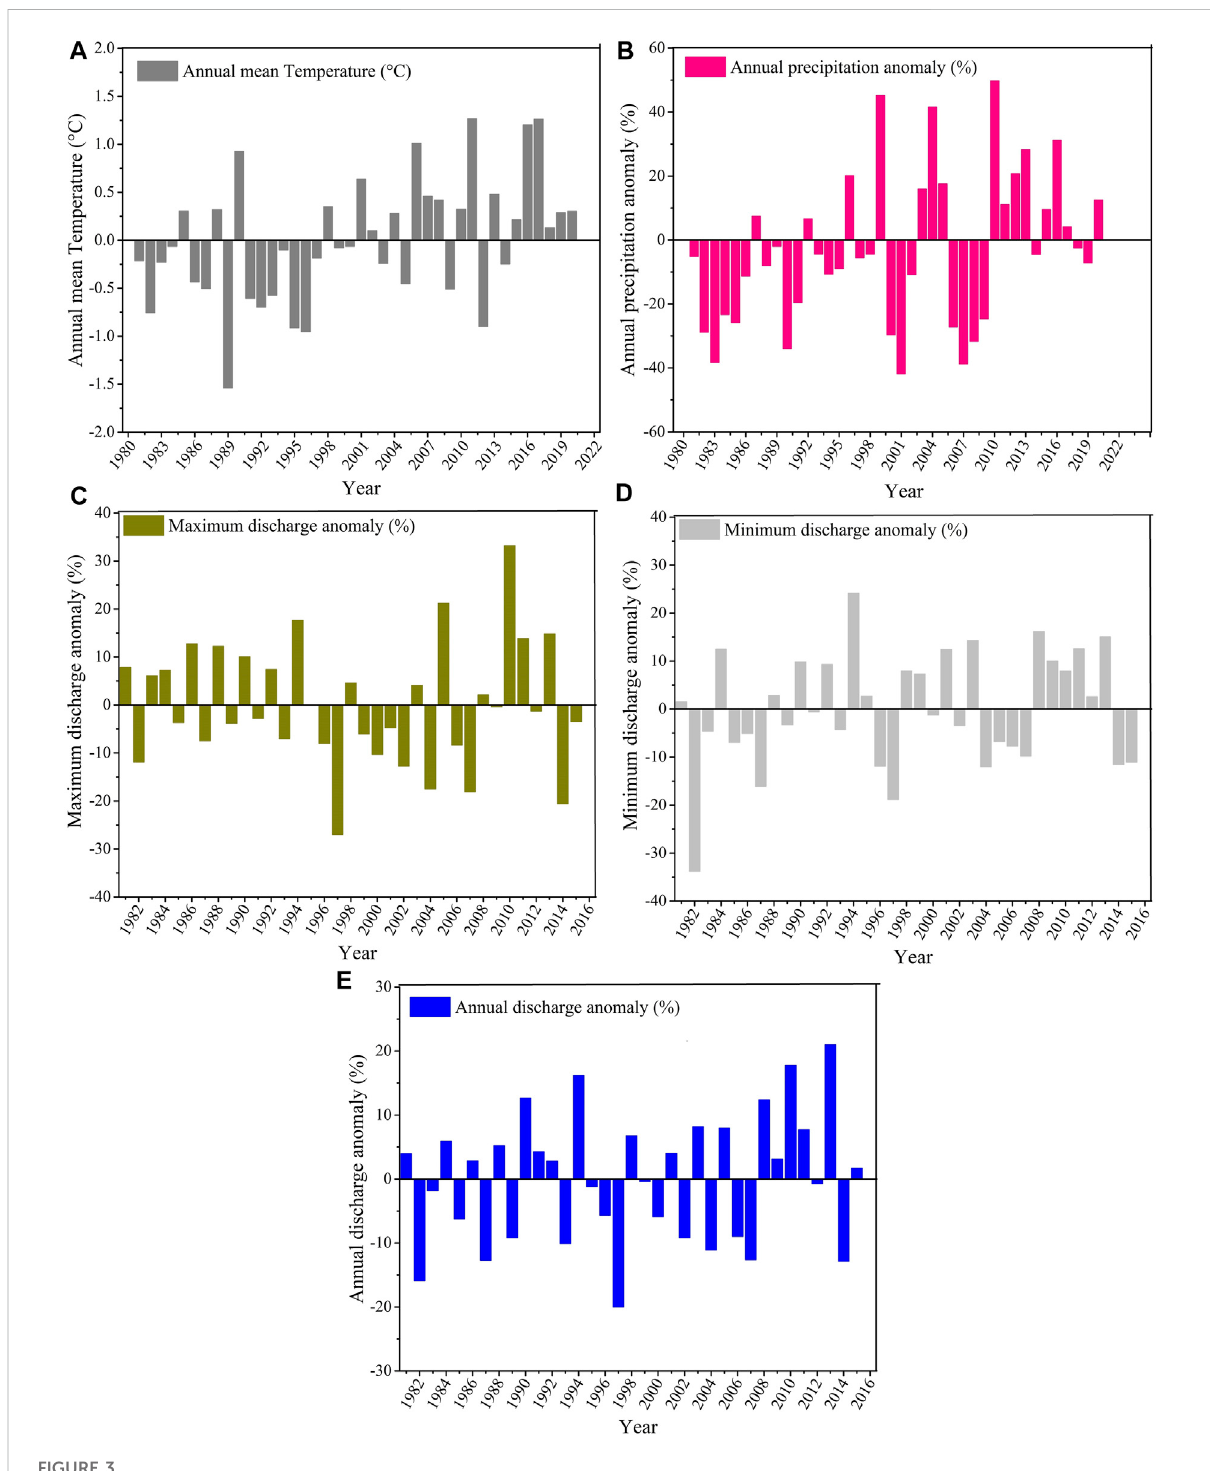
FIGURE 3 Regional anomalies of hydro-meteorological variables of the Gilgit River